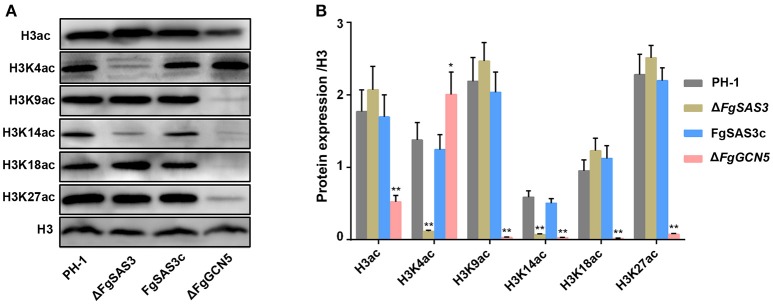
Western blotting analysis of proteins that extracted from PH-1, ΔFgSAS3, FgSAS3c, and ΔFgGCN5, respectively. (A) The respective strains were grown for 3 days in liquid TBI medium. The antibody anti-acetyl histone 3 (H3ac), anti-acetyl H3K4 (H3K4ac), anti-acetyl H3K9 (H3K9ac), anti-acetyl H3K14 (H3K14ac), anti-acetyl H3K18 (H3K18ac), and anti-acetyl H3K927(H3K27ac) were used for detection of alterations of acetylation levels. Antibody H3 was used as a loading reference. (B) Quantification of western blot signals in the three replicates. Data were expressed as mean IOD (relative to H3) ± standard error. *P < 0.05, **P < 0.01.